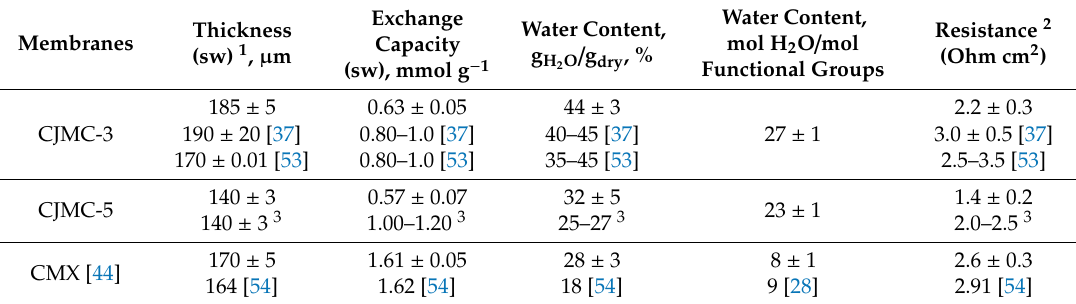
Table 1. Characteristics of swollen (sw) and dry membranes under